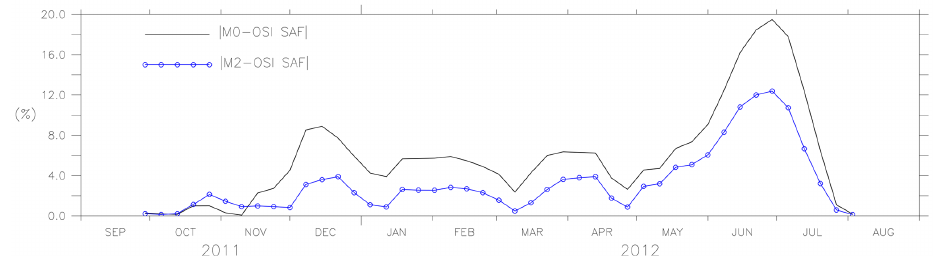
Figure 5. The absolute mean difference in ice concentration from October 2011 to July 2012. Ice concentration was not available for assimilation and hence model M2 will only be assimilated with SST during this